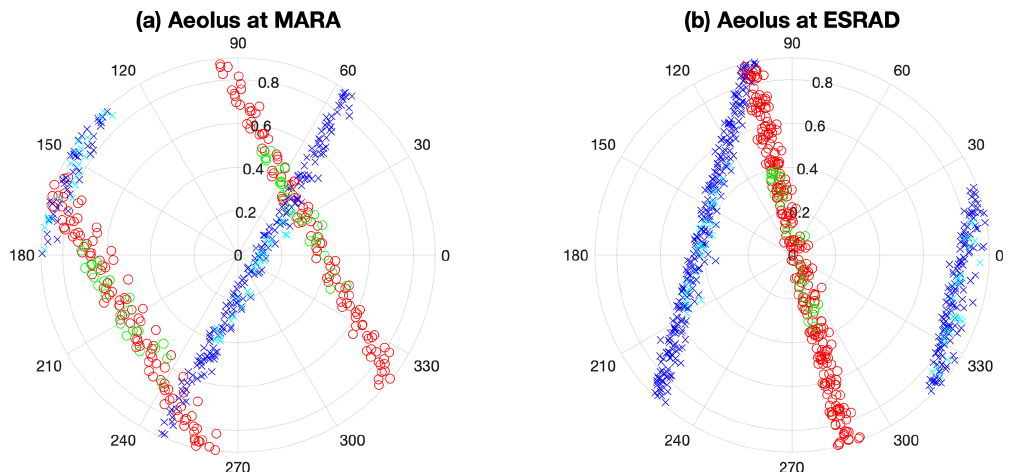
Figure 2. Polar plots of azimuth and angular distance ( ◦ ) from the radars of mean locations of all Aeolus wind profiles used for comparison. Mie profiles are shown in red for ascending tracks and blue is for descending ones. The along-track distance included in each Mie profile is about 14km (0.13 ◦ ). Rayleigh profiles are shown in green for ascending tracks and light blue for descending. The along-track distance included in each Rayleigh profile is about 87km (0.78 ◦ ). There are up to 14 (very sparsely populated) Mie cloudy profiles within 100km radius of the radar along each orbit track. These are combined to make a single profile for comparison with the single radar profile, as detailed in the